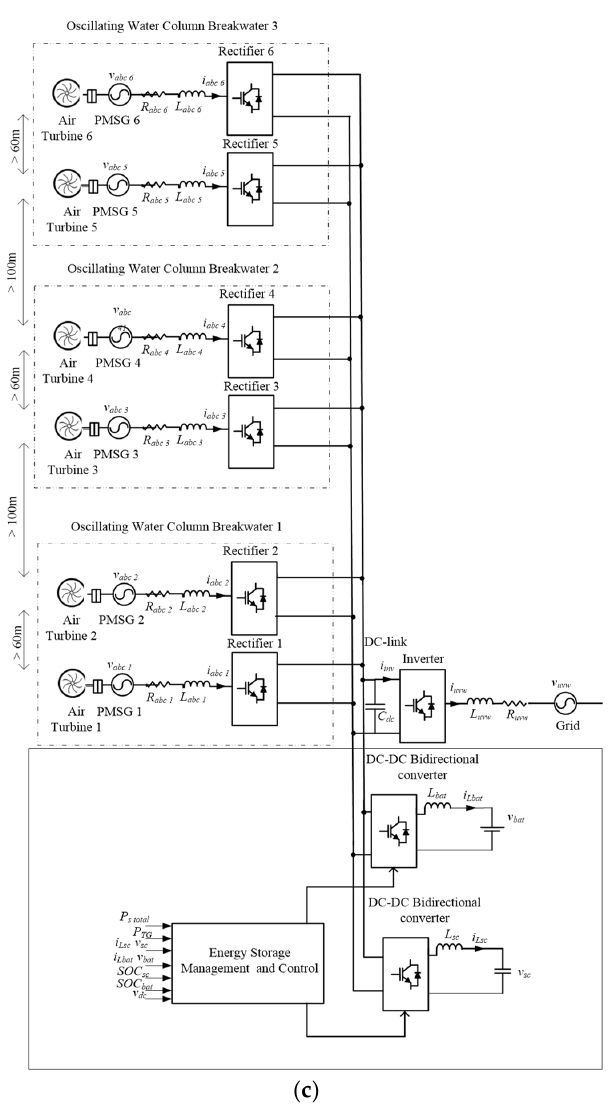
Figure 2. Schematic diagram of the electrical power conversion system. ( a ) single VOWC wage energy converter (WEC), ( b ) single VOWCDBW with two VOWC WECs, ( c ) hybrid array of VOWCs in the VOWCDBW.